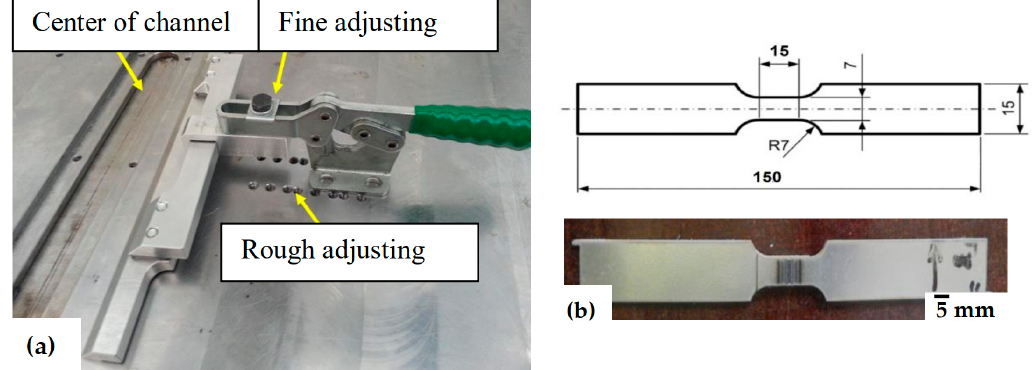
Figure 1. Presentation of ( a ) jig for clamping the work pieces during laser welding and ( b ) specimen for tensile-shear testing.